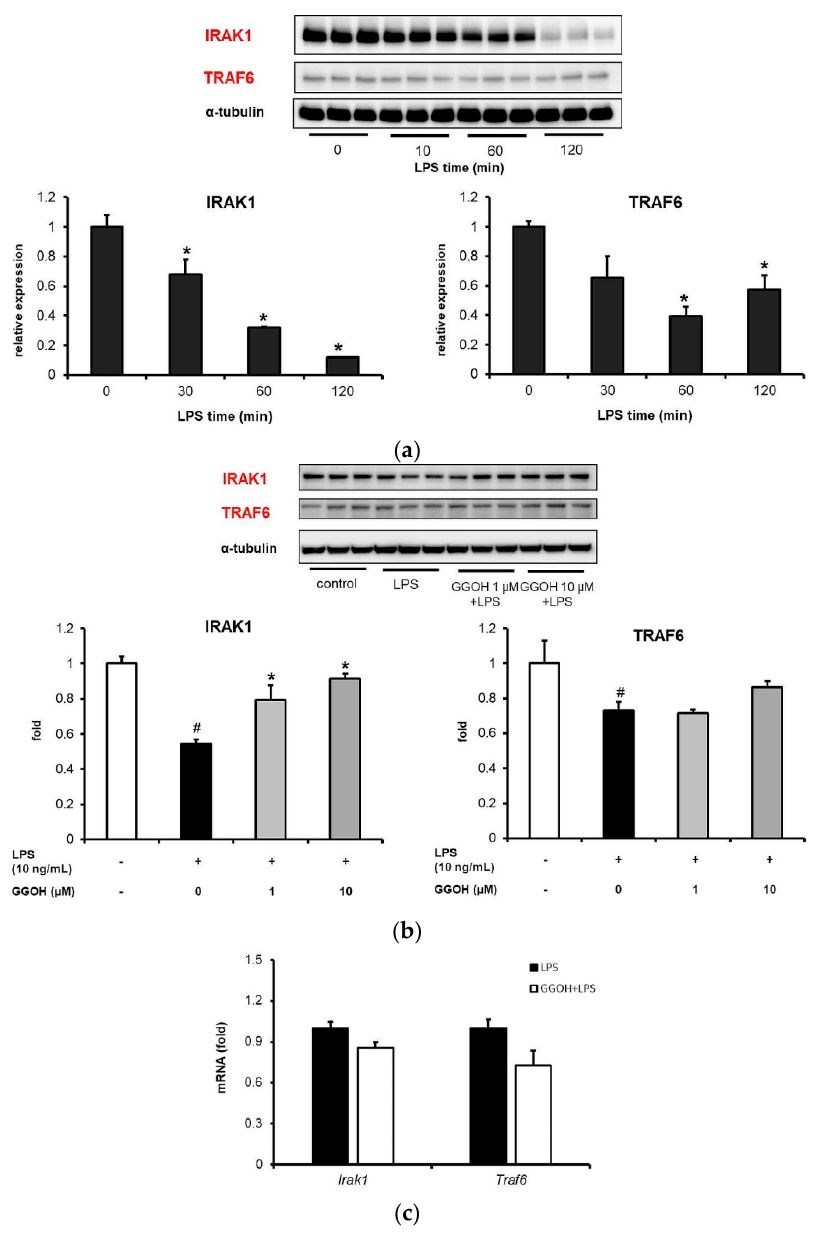
Figure 5. Reversal of LPS-induced NF- κ B upstream protein expression by geranylgeraniol (GGOH) administration. MG6 cells were pre-treated with GGOH for 24 h followed by LPS treatment (10 ng/mL) for 1 h. ( a ) Western blot images and quantifications of IRAK1 and TRAF6 expression levels after different LPS administration times. ( b ) Western blot images and quantifications of IRAK1 and TRAF6 expression levels in the presence of GGOH followed LPS treatment for 1 h. ( c ) Irak1 and Traf6 mRNA expression levels after 1 h of LPS treatment. Total cell lysates were collected and subjected to Western blot analysis or qRT-PCR. Data are presented as the mean ± S.E.M, n = 3, normalized to total protein levels detected based on α -tubulin or Eef1a1 as internal standards. # p < 0.05 vs. untreated control; * p < 0.05 vs. LPS-only treatment or LPS in 0